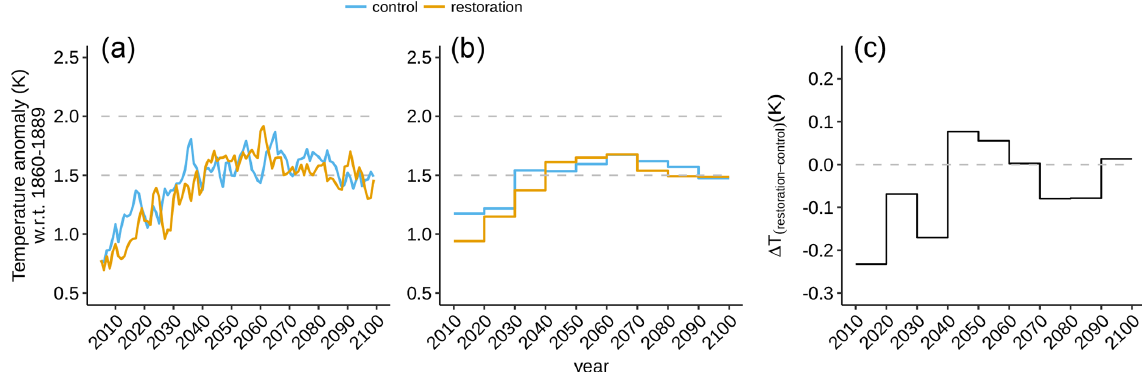
Figure 6. Global temperature time series showing (a) annual averages and (b) decadal averages for the restoration (yellow) and control (blue) simulation; (c) decadal difference between both